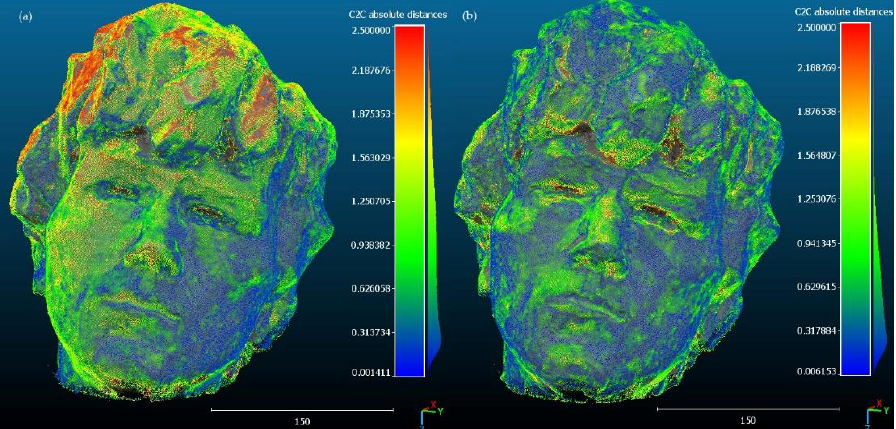
Figure 5. Deviations between the reference model and the model from Samsung Galaxy S10 images: ( a ) with self-calibration, ( b ) with pre-calibration.